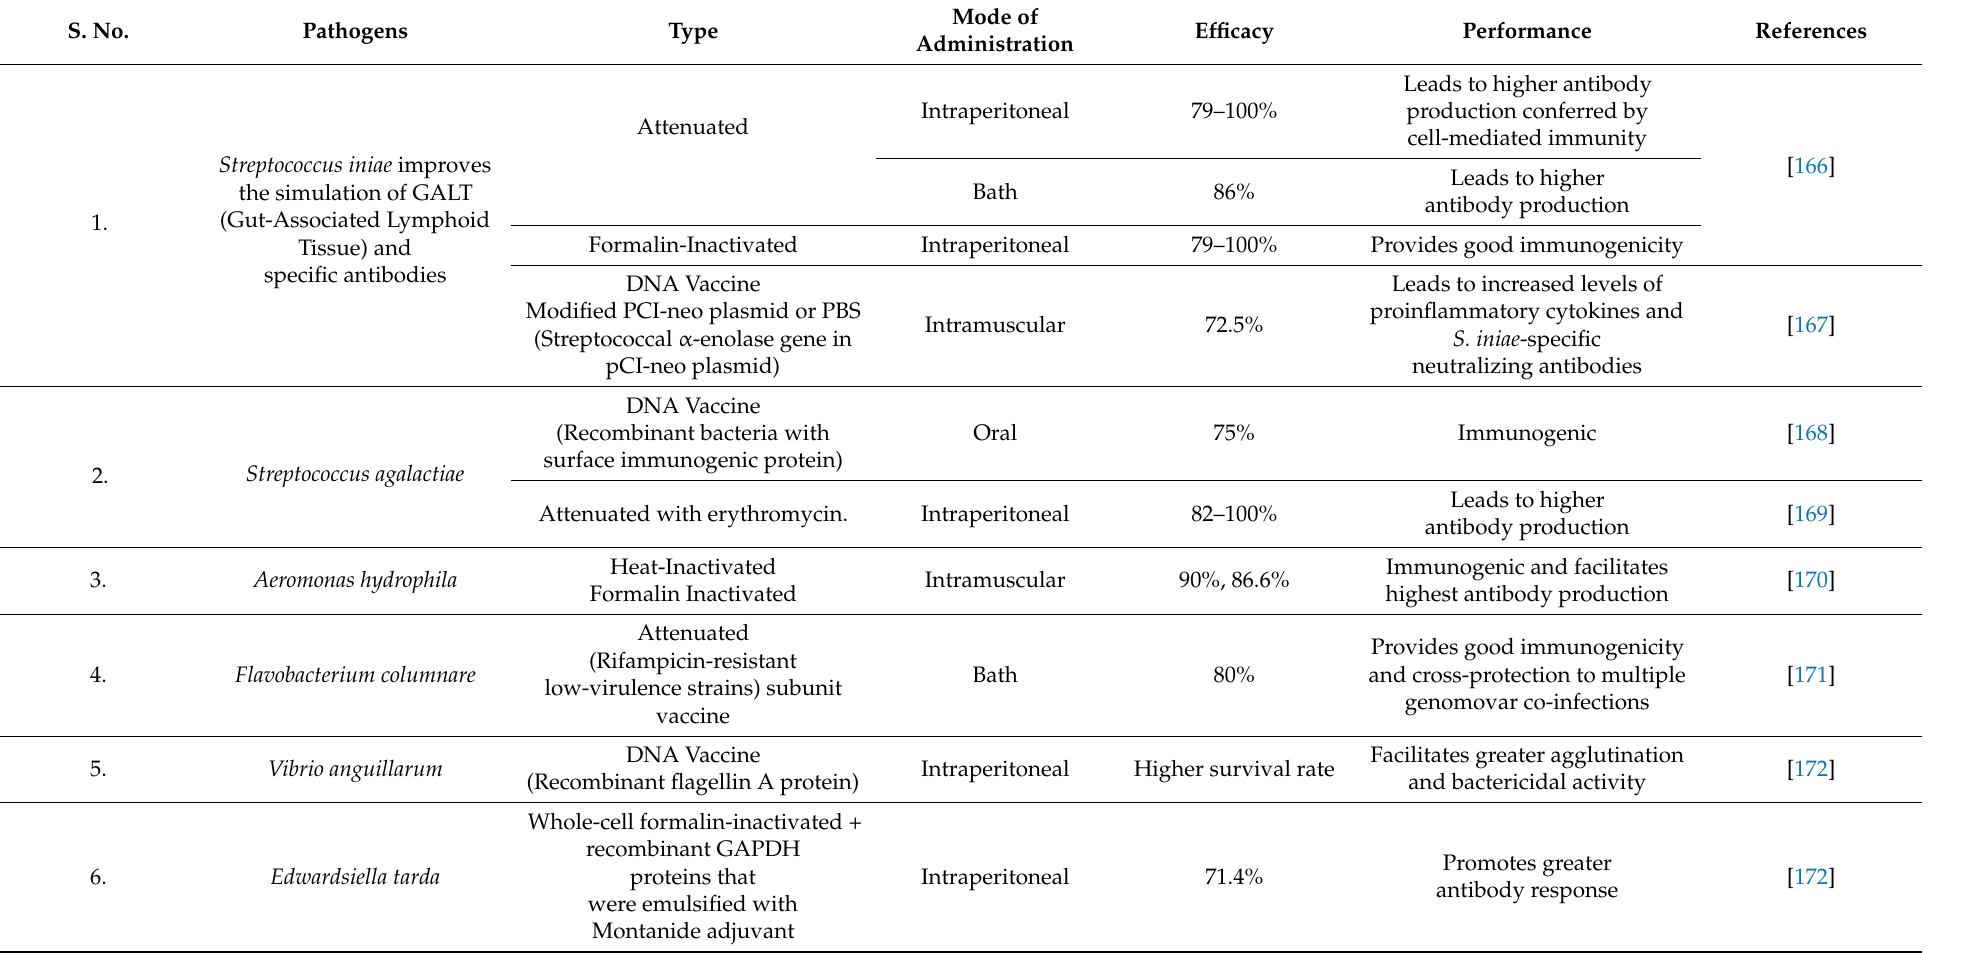
Table 2. Bacterial vaccines administered for